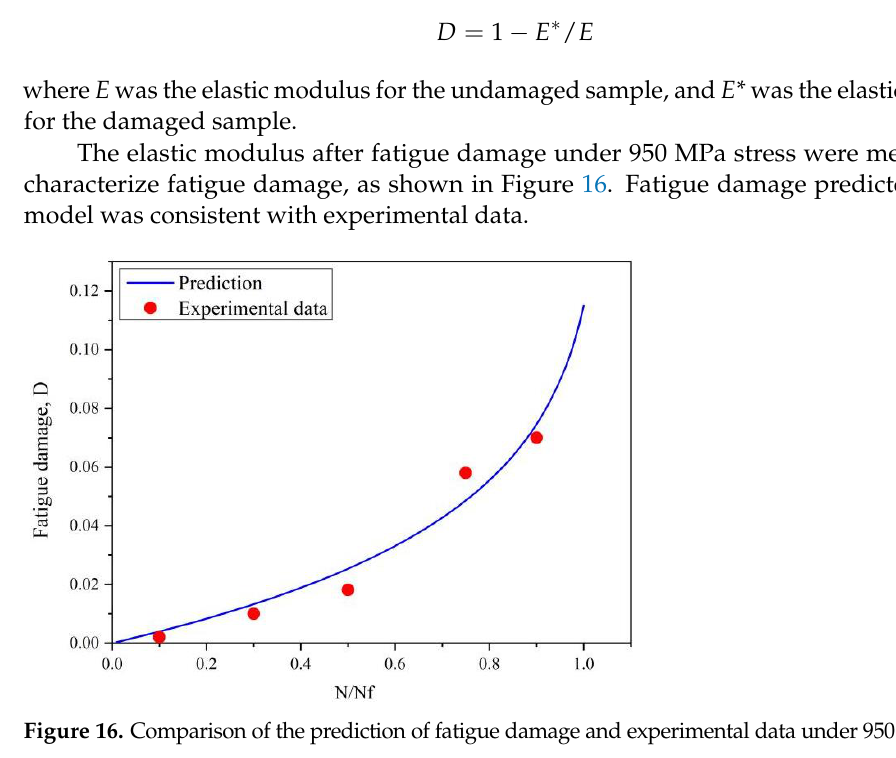
Figure 15 . Fitting of damage mechanics parameters for low cycle fatigue life of TC21 titanium alloy.